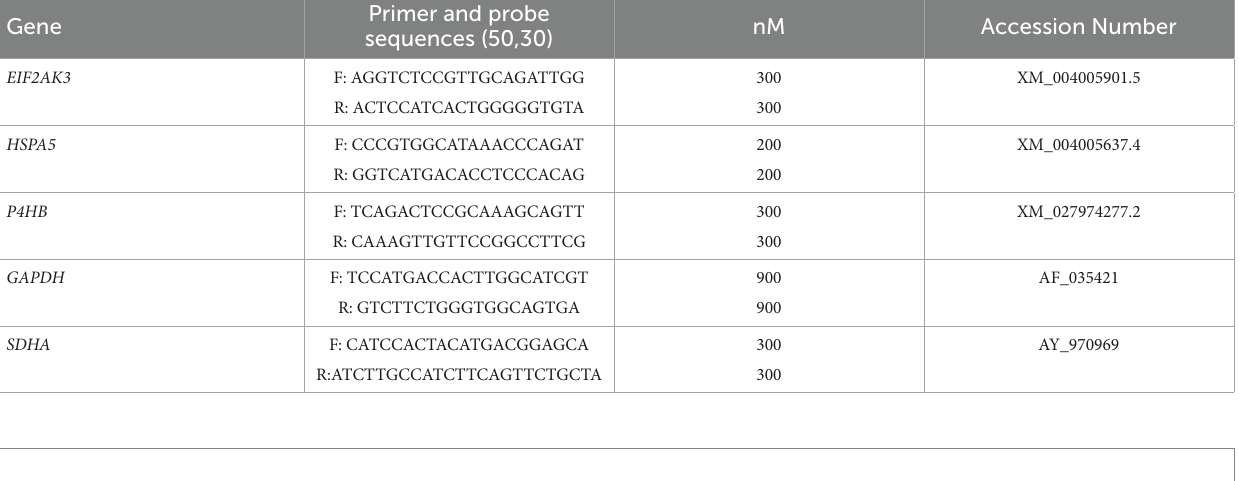
TABLE 2 Primers used for the genomic